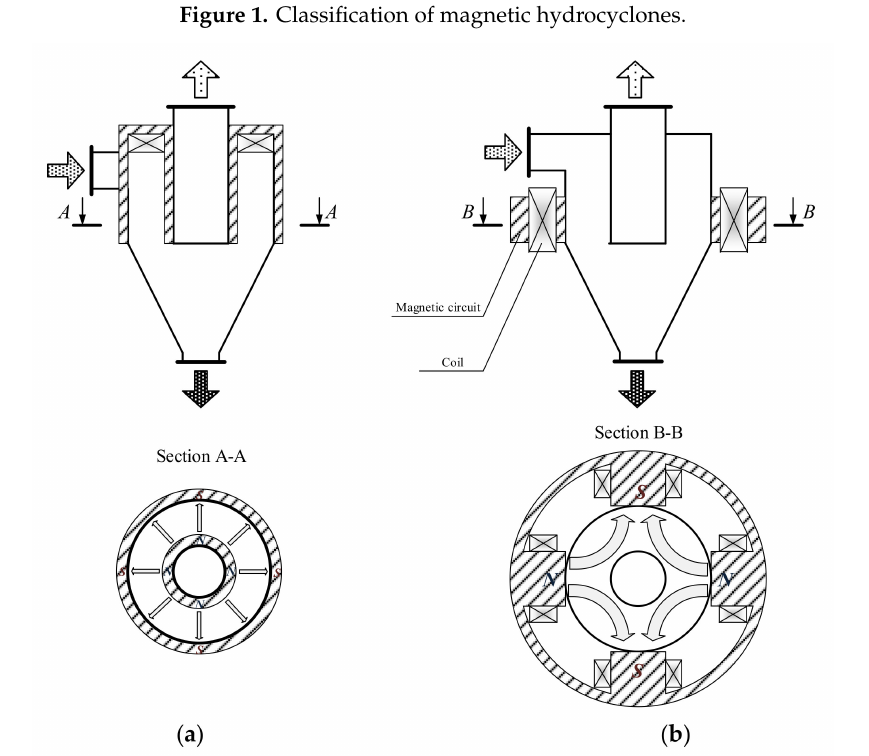
Figure 2. The Fricker hydrocyclone ( a ) and the Watson hydrocyclone ( b